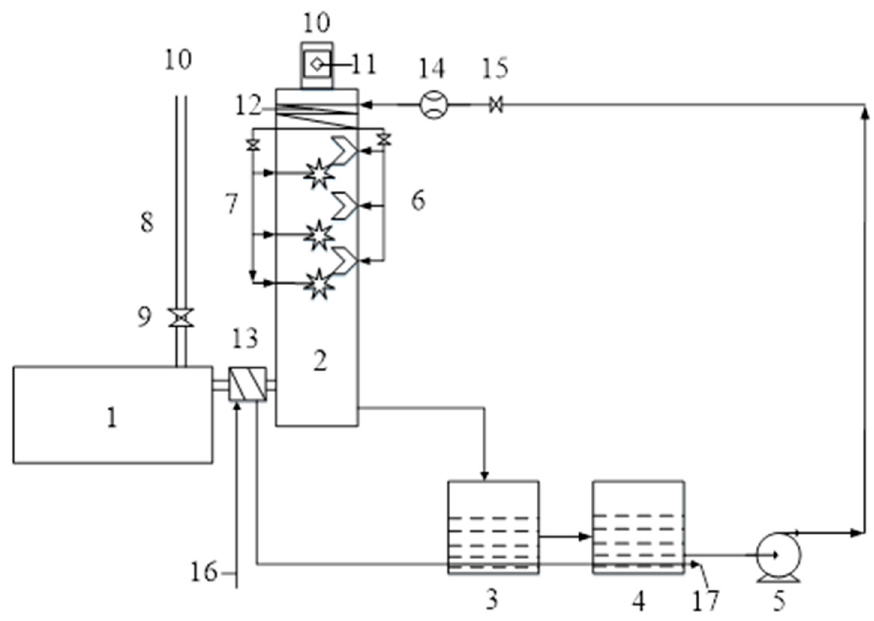
Figure 1. System for the recovery of ship’s CO 2 . 1—6135G128ZCa marine diesel engine; 2—spray